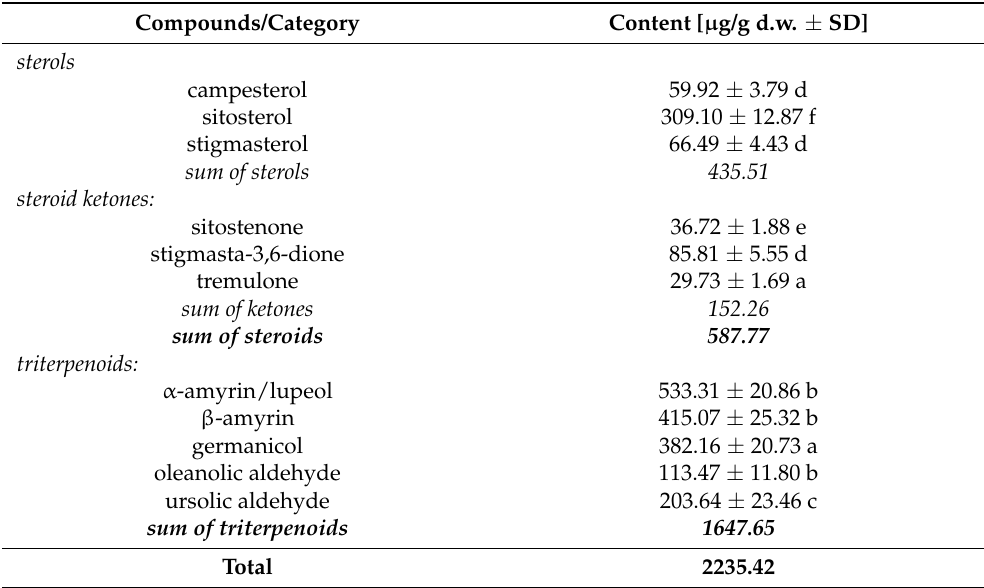
Table 5. Content of steroids and triterpenoids in Rhamnus alaternus leaves.